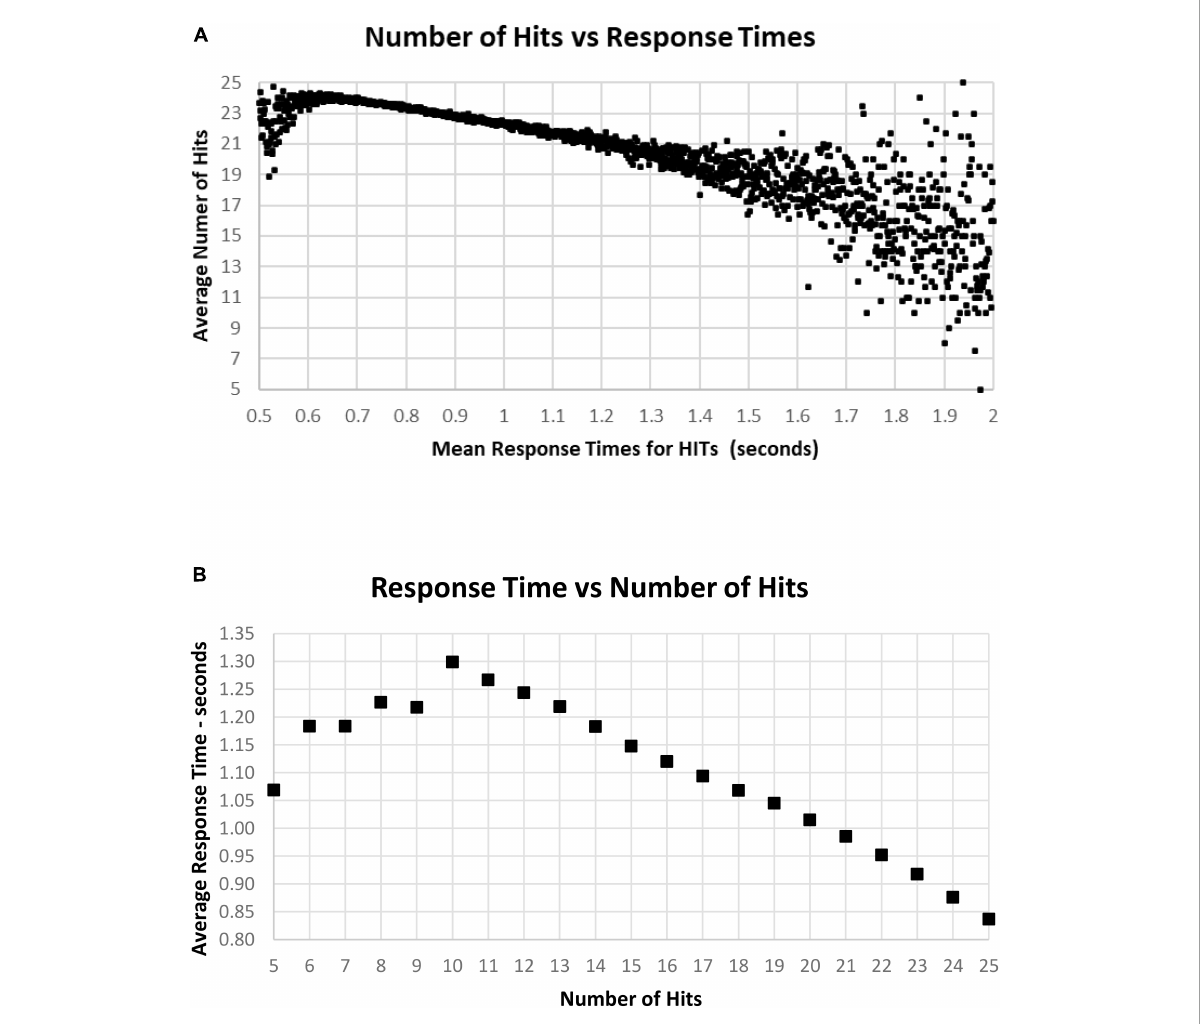
FIGURE11 (A) Average number of HITs for each RT, showing the HIT component of correct responses. Note that the most rapid average RT is about 0.650 with an average of 24 HITs. There is a relatively small number of faster responses, most with over 21 HITs. Beyond 1.4 s, there is again a smaller number of tests, and the wide distribution of responses reflects that smaller number. (B) Same data as (A) , showing the optimal number of HITs, 25, is associated with an average RT of 0.837 s, with a progressive slowing associated with fewer HITs to an RT of 1.299 s at 10 HITs. With a smaller number of HITs, there is a faster RT, reflecting a lower level of